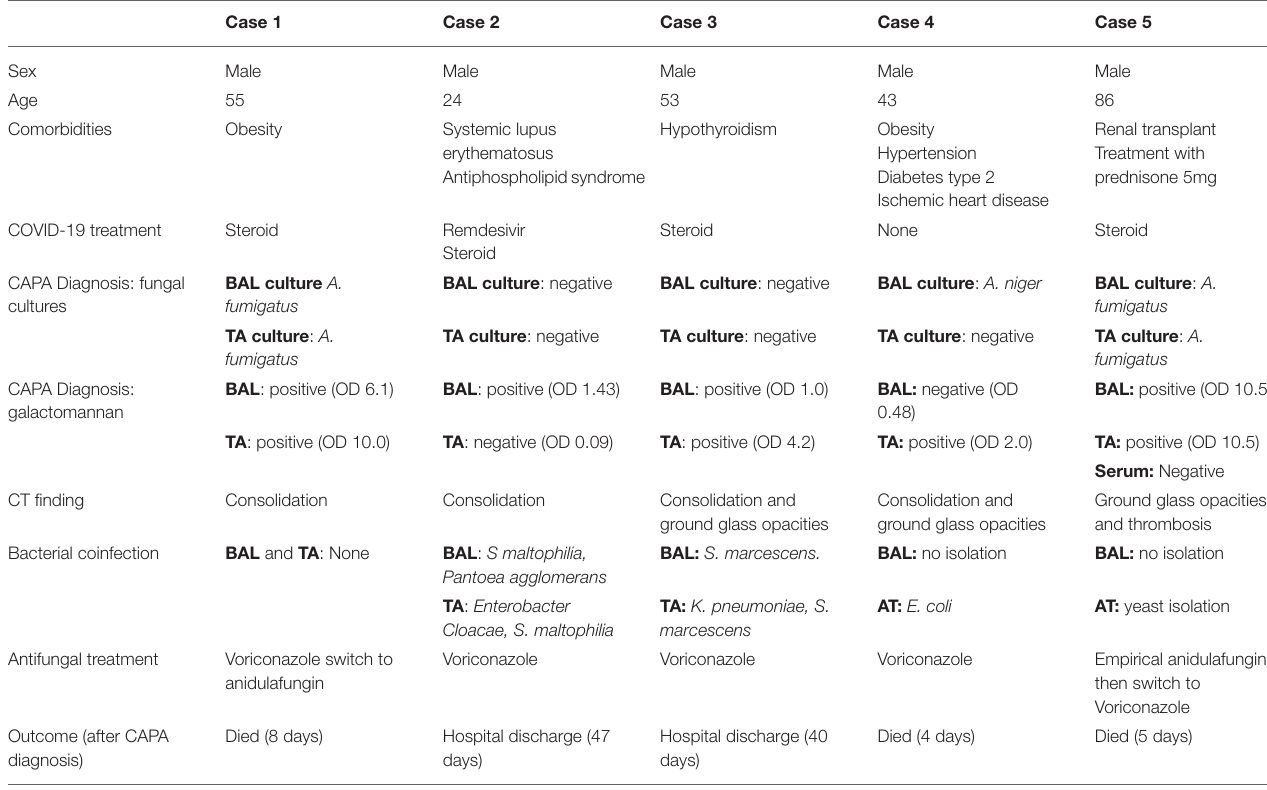
TABLE 2 | Clinical and microbiological characteristics of patients with